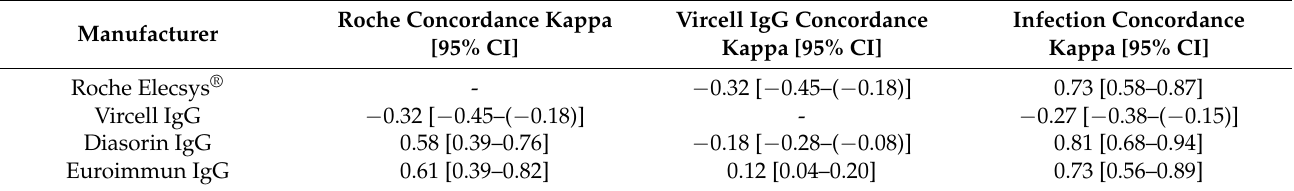
Figure 2. Antibody response against SARS-CoV-2 nucleocapsid protein in the study cohort of health care workers; Roche Elecsys ® on the left and Vircell IgG on the right. Subjects were grouped according to their infection status. Boxplots represent the quantification of the distribution of anti-nucleocapsid protein antibodies; upper and lower bounds of the boxes indicate 75th and 25th percentiles, respectively. The dotted horizontal line indicates the cut-off point of each immunoassay. Table 2. Commercial immunoassay concordance in discrepant samples from the study cohort ( n = 164).